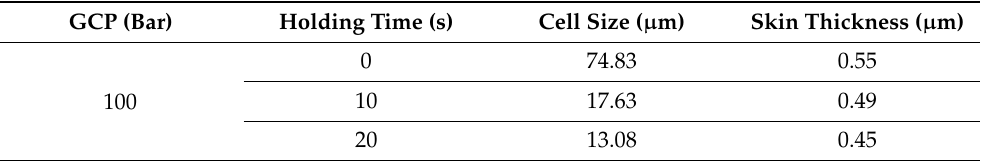
Table 2. Average cell size and skin thickness of the microcellular injection molding with GCP and different holding